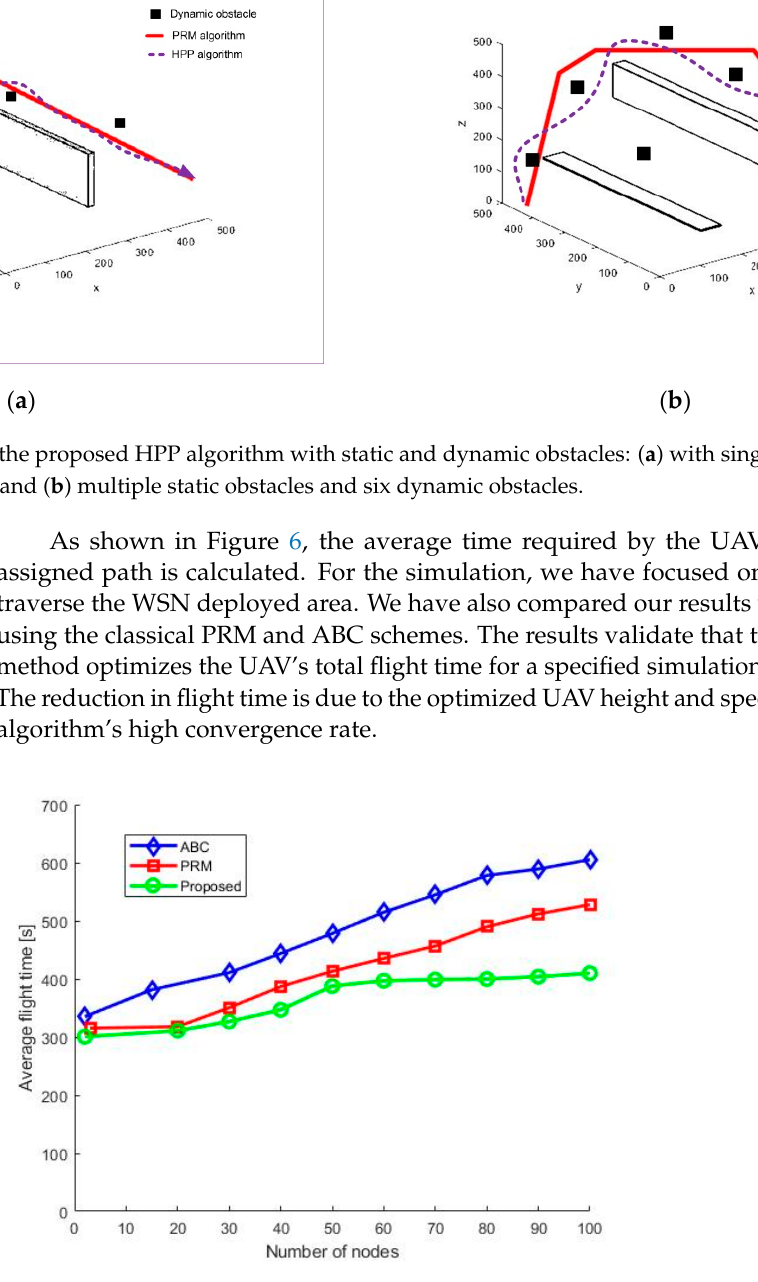
Figure 6. Average flight time of UAV in the network.